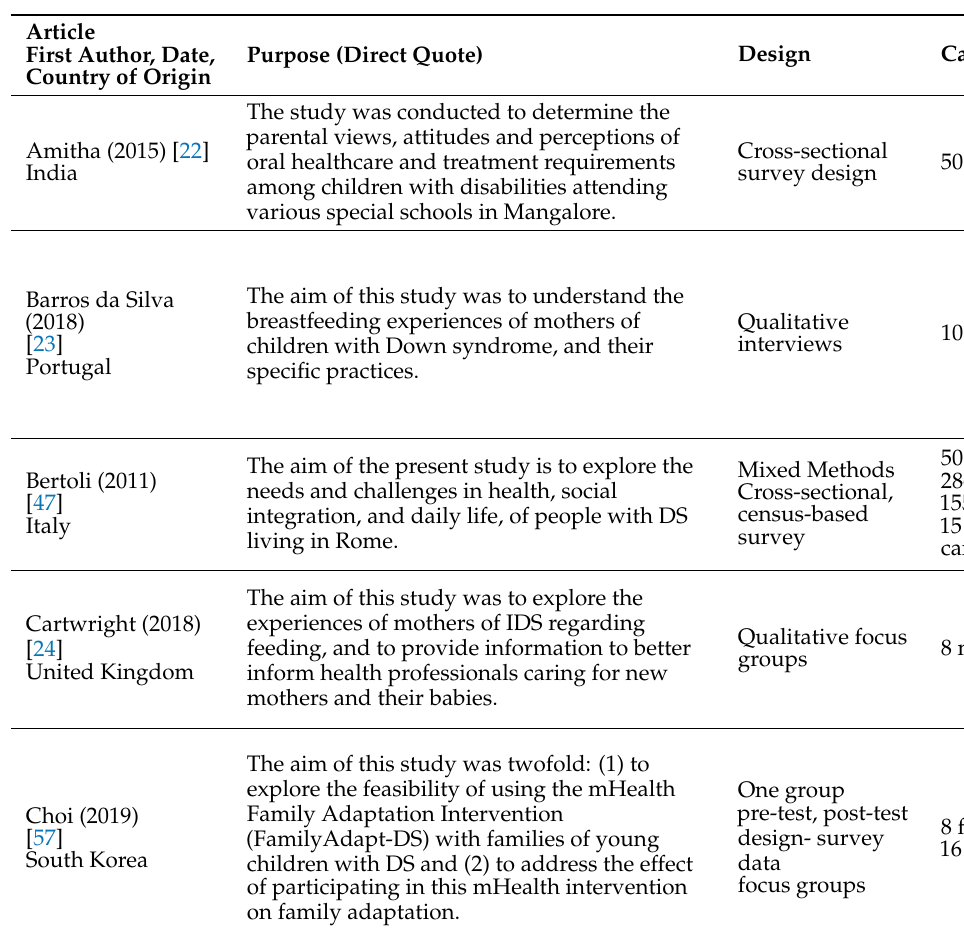
Table A1. Overview of article data